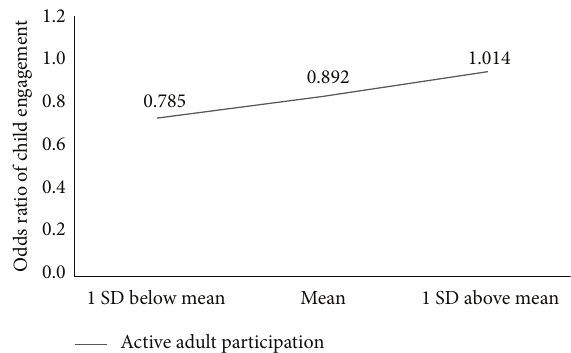
Figure 1: Interaction of active adult participation and child ASD severity on child